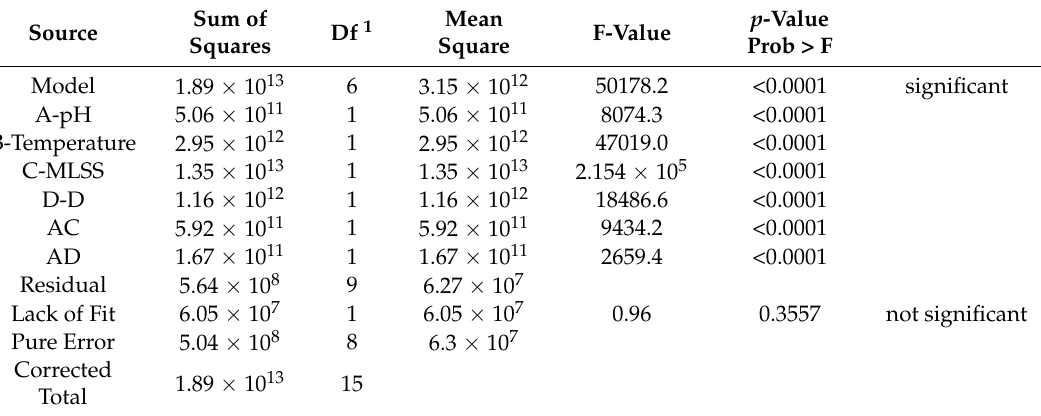
Table 6. Analysis of variance table for the selected factorial model (Partial sum of squares-Type